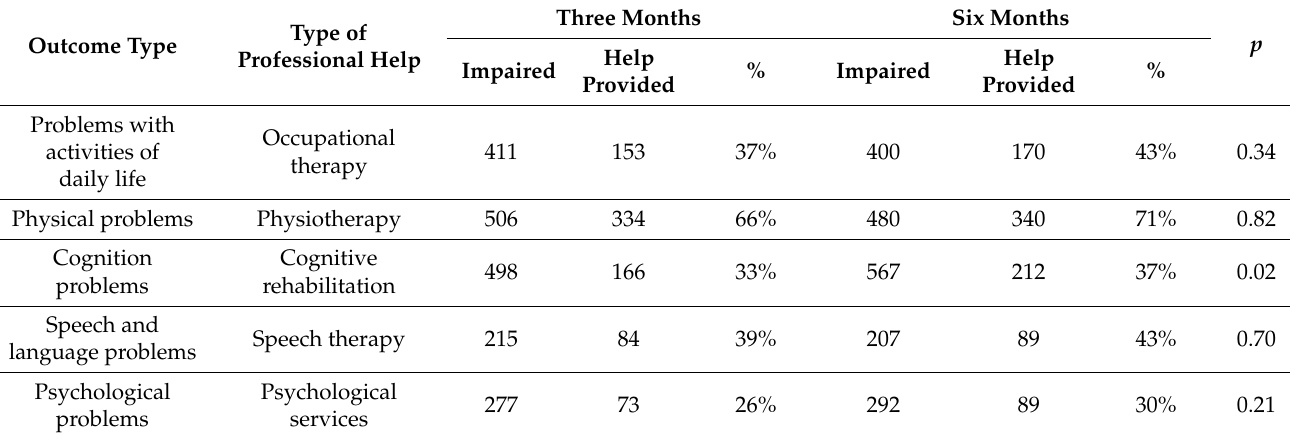
Table 3. Professional help provided for patients with impaired outcomes at three and six